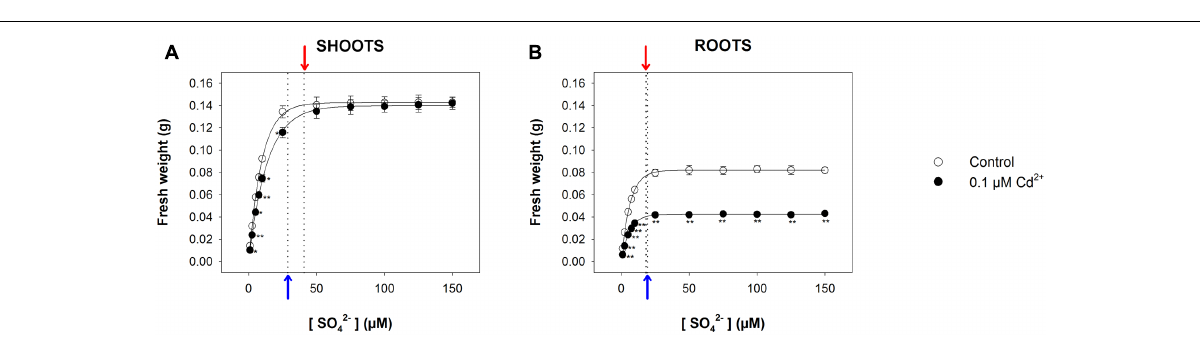
FIGURE 4 | Effect of long-term exposure to Cd on shoot and root growth as a function of the sulfate concentration in the external medium. Arabidopsis plants were grown for 22 days under a wide range of sulfate concentrations (1, 2.5, 5, 7.5, 10, 25, 50, 75, 100, 125, and 150 µ M) in the presence or absence of 0.1 µ M Cd 2 + . The characteristic curves describing shoot and root fresh weight accumulation in relation to the external sulfate were drawn by fitting a three-parameter exponential rise to maximum function to the data obtained by weighing the shoot and the roots of the Arabidopsis plants at the end of each experiment. (A) Shoot fresh weight accumulation. The correlation coefficients of the fittings were 0.999 and 0.999, for control and Cd-exposed plants, respectively. (B) Root fresh weight accumulation. The correlation coefficients of the fittings were 0.999 and 0.999, for control and Cd-exposed plants, respectively. Data are means and SE of two experiments run in triplicate ( n = 6). Asterisks indicate significant differences (Student’s t -test; ∗ 0.001 ≤ P < 0.05; ∗∗ P < 0.001) between control and Cd-exposed plants grown under the same sulfate external concentration. Blue and red arrows indicate the values of [SO 42 − ] crit calculated for control and Cd-exposed plants,